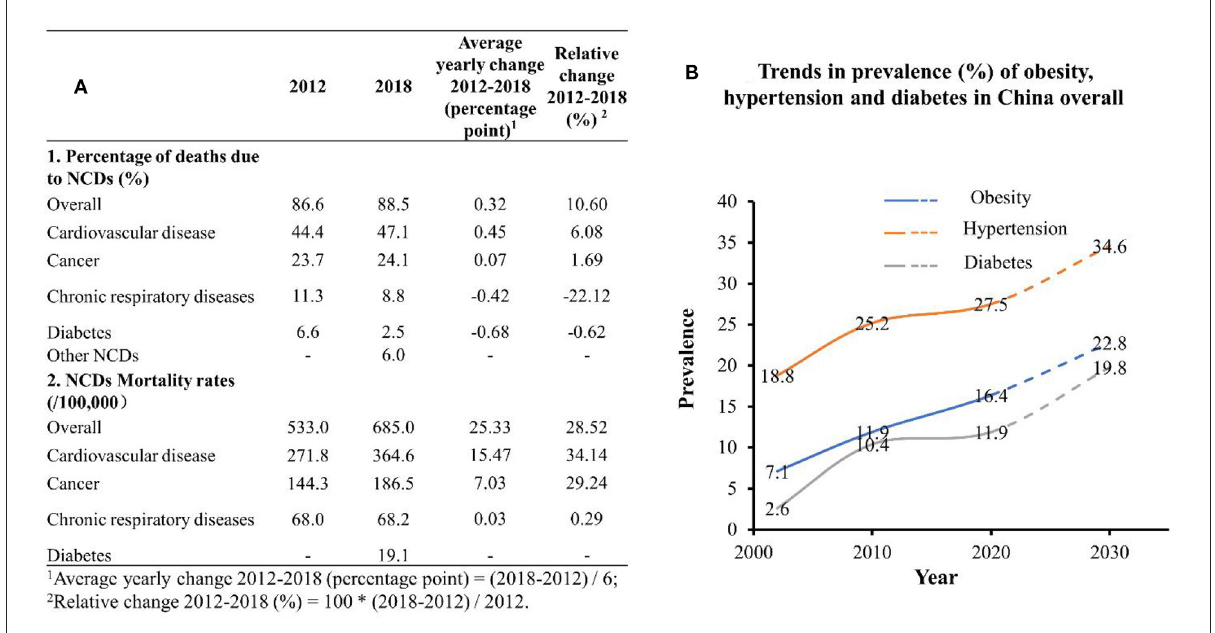
FIGURE2 Trends in major NCD mortality and prevalence in China overall, 2002–2030. (A) Data were from the Report on Nutrition and Chronic Disease Status of Chinese Residents (2015) and the Report on Nutrition and Chronic Disease Status of Chinese Residents (2020); (B) data were from the China Chronic Disease and Risk Factor Surveillance Report (2013), Report on Nutrition and Chronic Disease Status of Chinese Residents (2015), and the Report on Nutrition and Chronic Disease Status of Chinese Residents (2020). NCD, non-communicable disease.